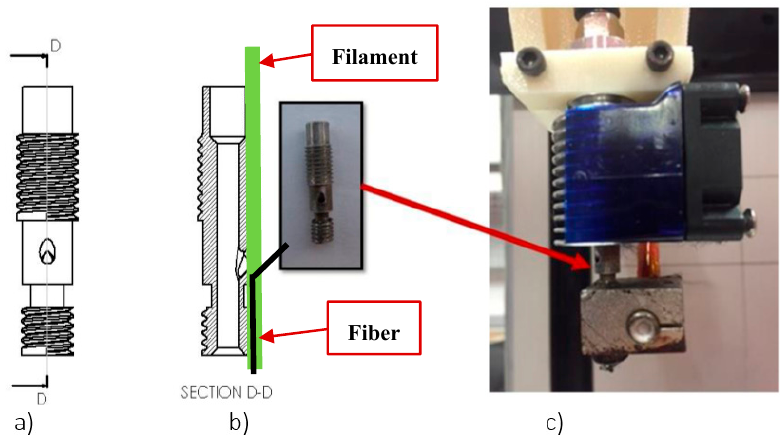
Figure 5. Fiber deposition nozzle with thermal cut detail: ( a ) main view; ( b ) cut view showing filament and fiber yarn; ( c ) real deposition head.